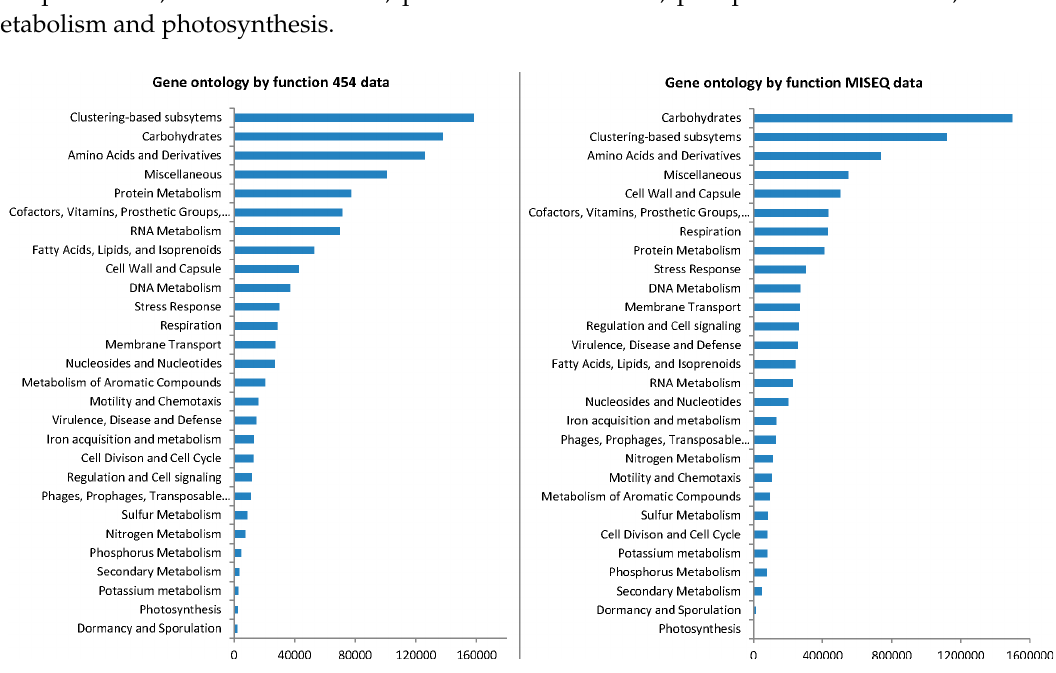
Figure 4. Gene Ontology by function.